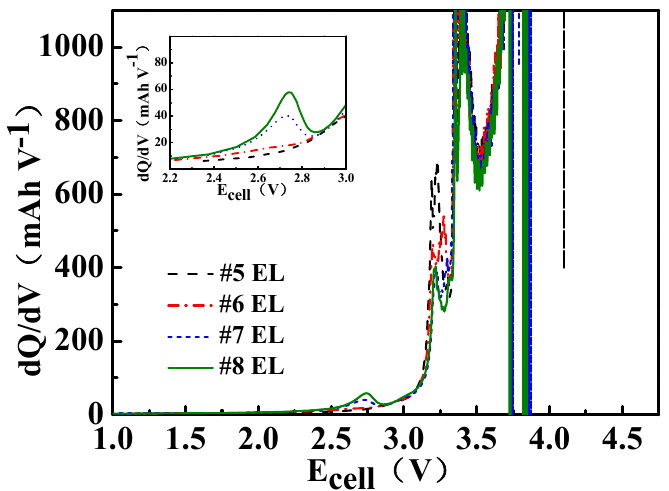
Figure 4. The dQ/dV plots of the assembled full cell.